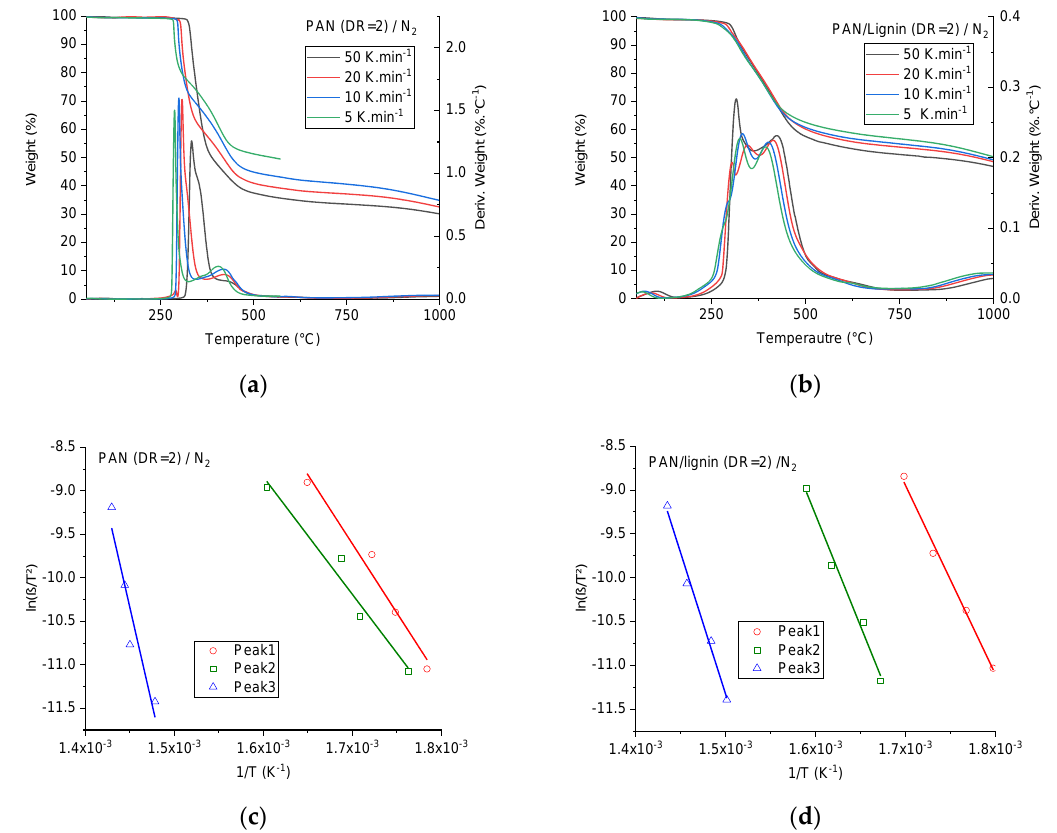
Figure 8. Thermogravimetric analysis (TGA) curves of the ( a ) PAN fibers at a DR of 2 and ( b ) PAN/lignin fibers at a DR of 2 and at different heating rates up to 1000 °C under nitrogen; evaluation of the activation energy of different characteristic thermal degradation processes using the Coats–Redfern method for ( c ) PAN fibers and ( d ) PAN/lignin fibers. For more details about the peak ID assignments, please refer to Supplementary Data Figure S3.